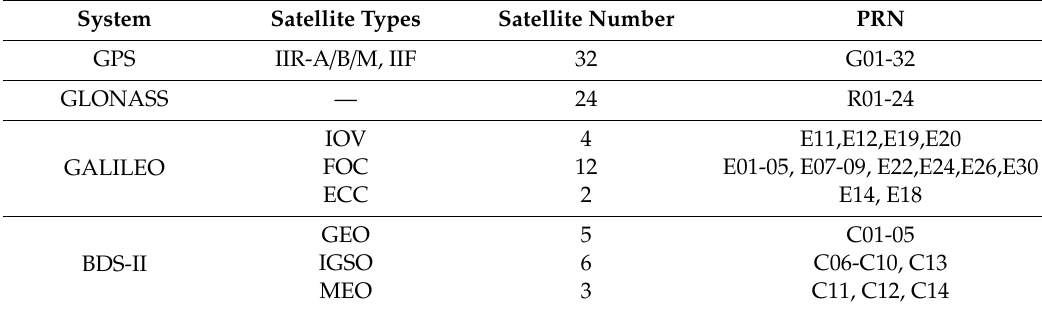
Table 1. Available satellites of each system as of January